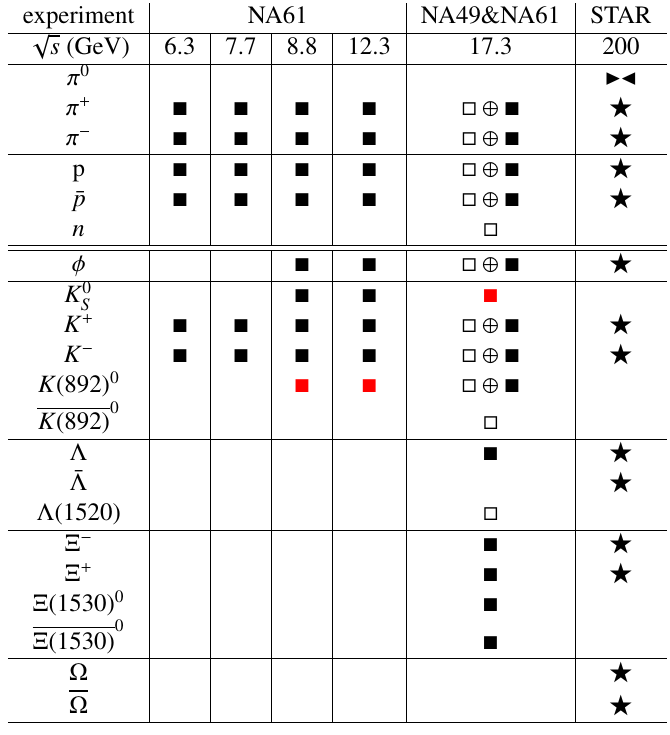
Table 1. Summary of experimentally measured total particle yields in pp collisions. The lines separate the following particles: (i) light non-strange mesons, (ii) non-strange baryons (iii) hidden strangeness meson, (iv) open strangeness mesons, (v) results are denoted: □ = NA49, ■ = NA61 / SHINE, □